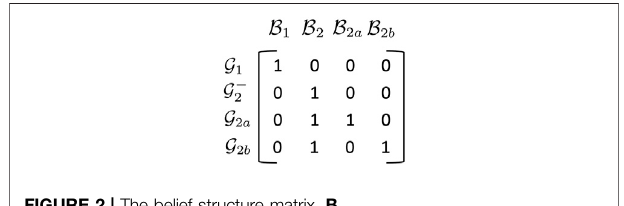
FIGURE 2 | The belief structure matrix, B